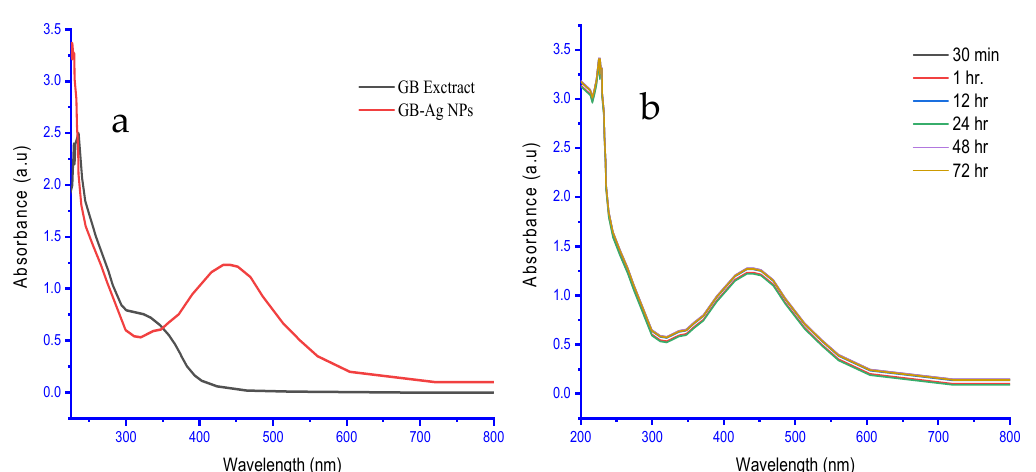
Figure 5. The UV–Vis spectroscopy of ( a ) the GB extract and as-biofabricated Ag NPs and ( b ) Ag NPs show good stability at regular intervals (for 3 days).